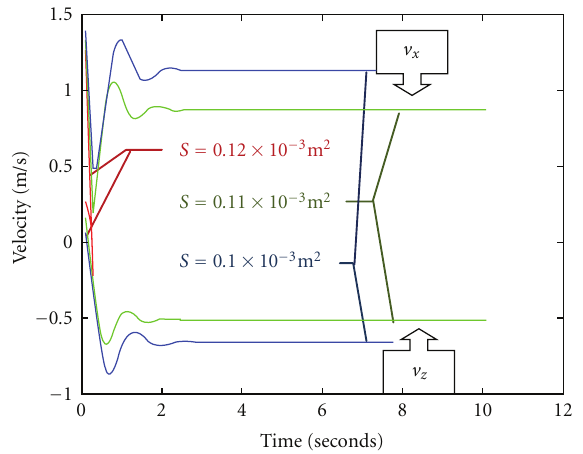
Figure 13: Dragonfly flapping straight—changing the weight. Distance versus time.